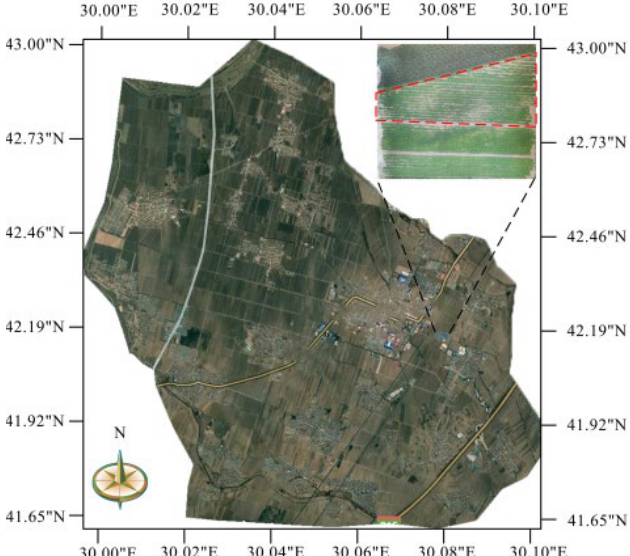
Figure 1. Location and overview of the experimental site. Table 1. Disease severity levels at the leaf